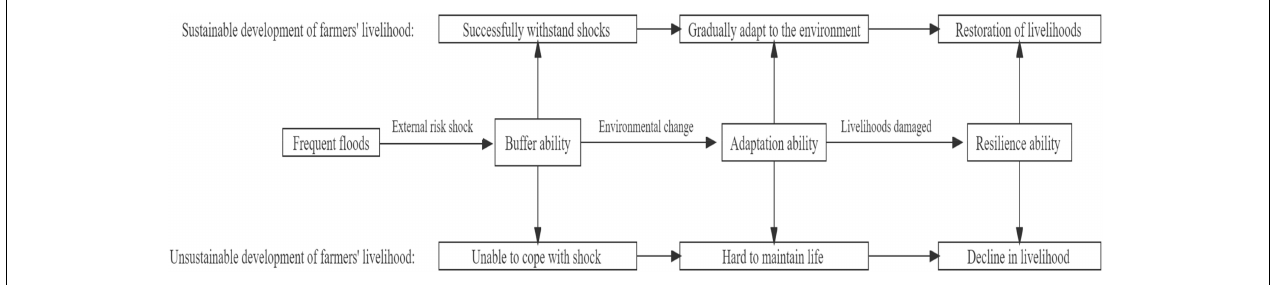
FIGURE 1 | Transmission pathways of the impact of flooding on the livelihood resilience of farm